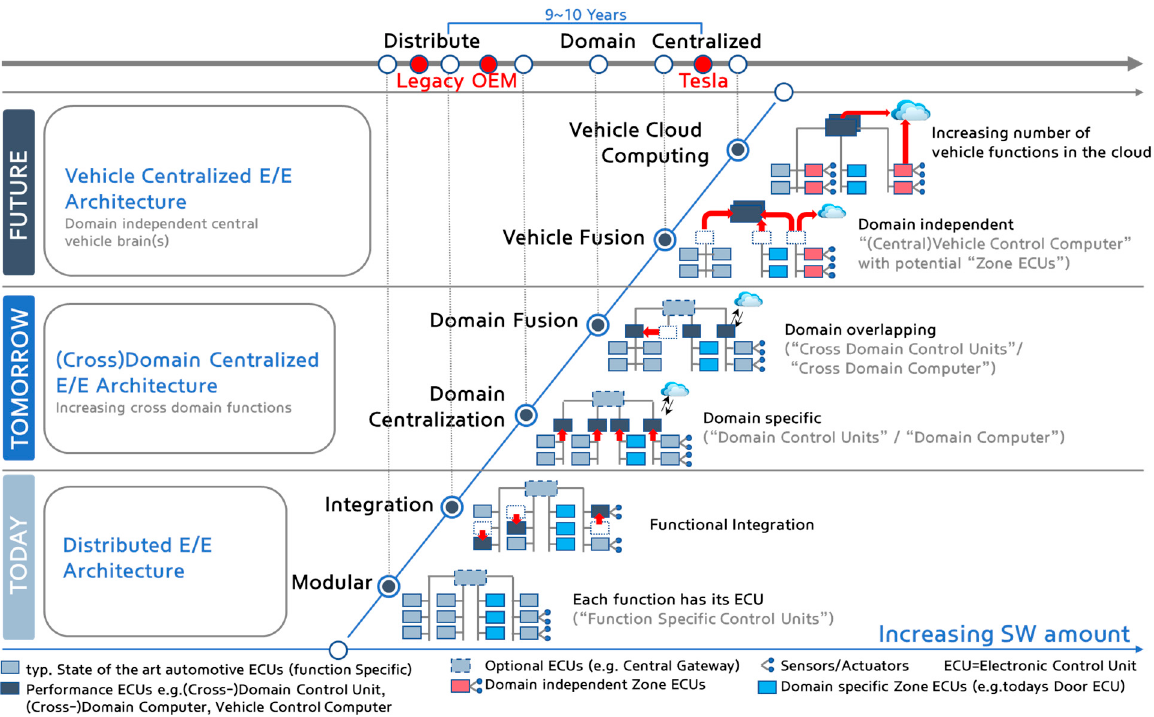
Figure 1. Possible evolution of vehicular E/E architectures (Revised)